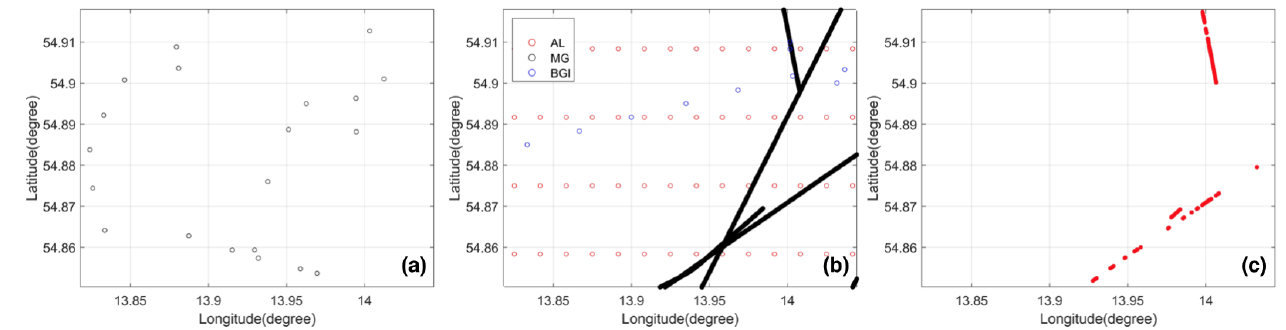
Figure A1. Data: ( a ) the control points from the EMODnet model; ( b ) gravity data: red, black and blue points are gravity points from satellite altimetry, marine gravimetry and BGI data set, respectively; ( c ) checking points from ship-sounding